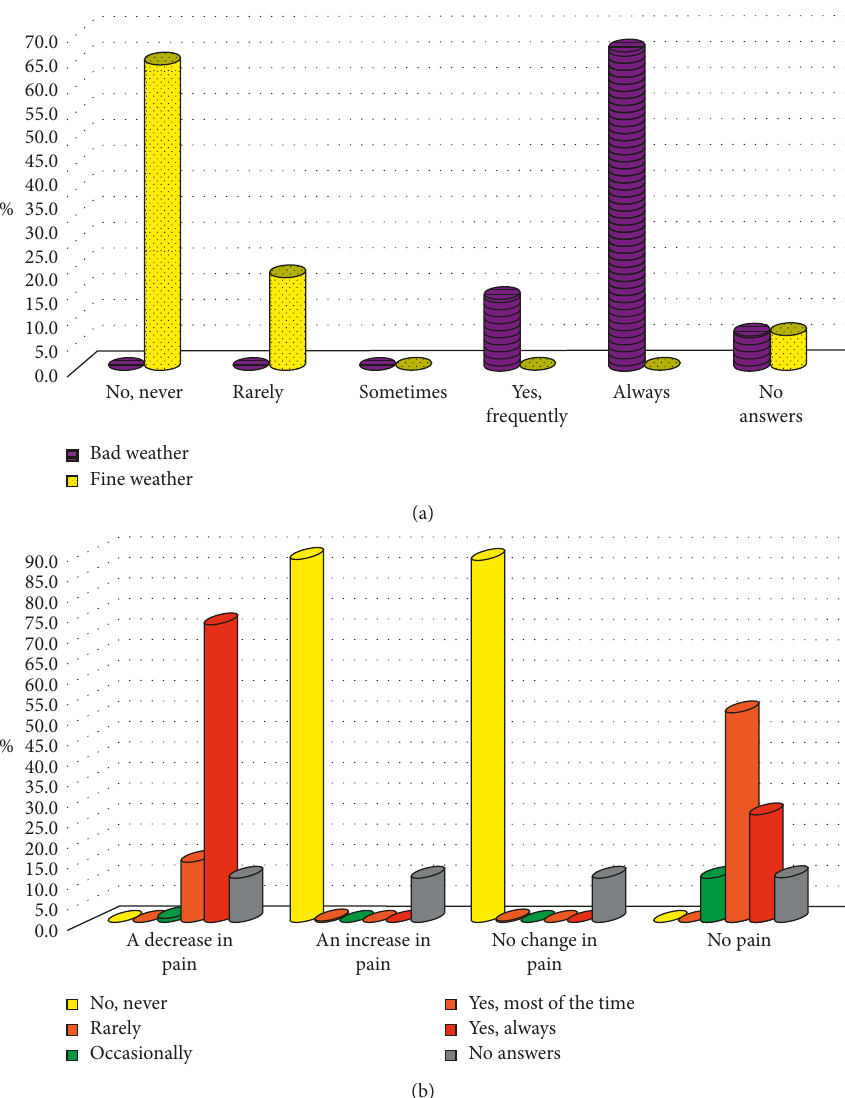
Figure 3: Frequency of pain intensification in WeCos in general (Q9) (a) and in fine weather (Q10) (b). 0.010.020.030.040.050.060.070.080.090.0